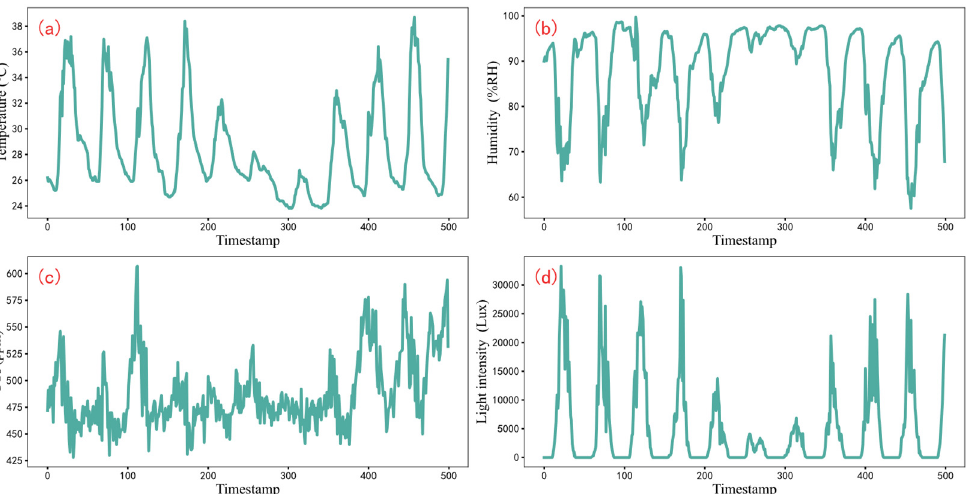
Figure 5. Display of data used in the experiment. ( a ) the temperature data, ( b ) the humidity data, ( c ) the CO 2 content data, and ( d ) the light intensity data.